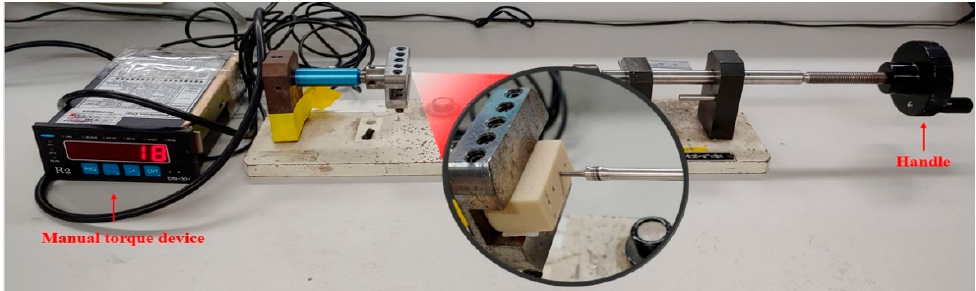
Figure 7. Insertion torque measurement using the manual torque device.